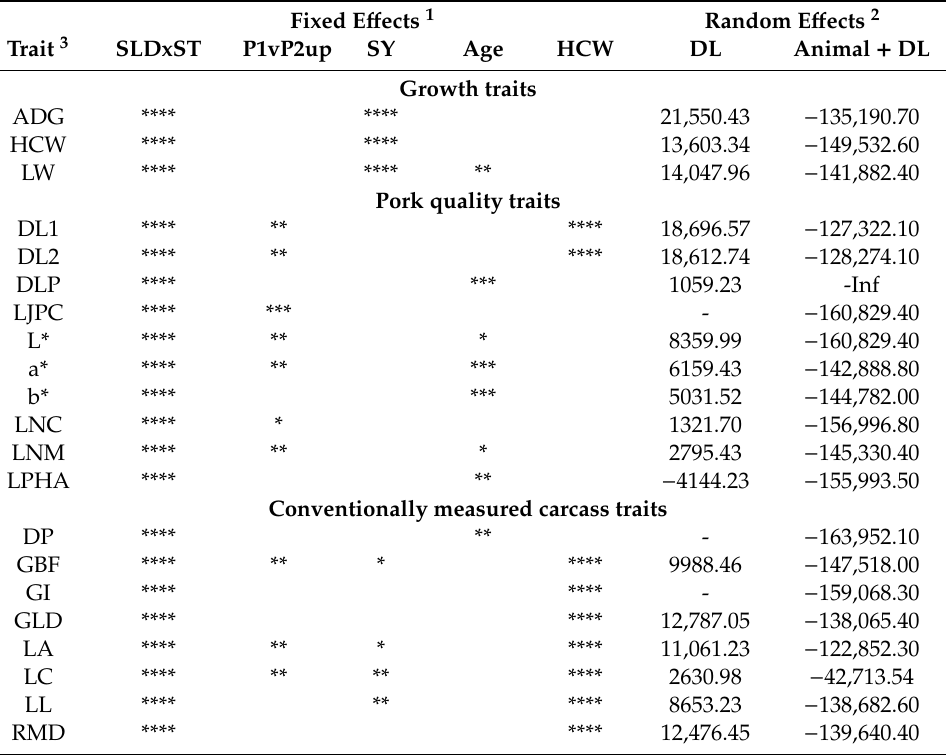
Table 4. Significance of covariate and categorical fixed e ff ects tested for growth, pork quality and conventionally measured carcass traits; and the di ff erent AIC values obtained among the models with and without the random e ff ect of dam-litter (DL).